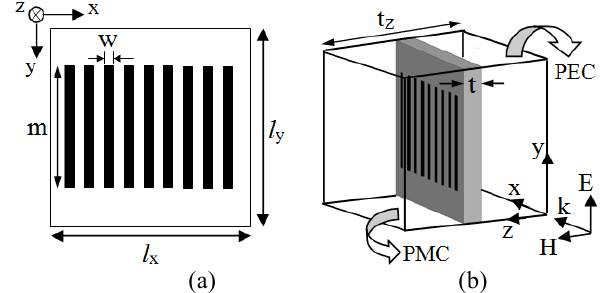
Figure 1: The geometry (a) unit cell metamaterial, (b) its simulation model. The dimensions of unit cell are l x = l y = 6 mm, w = 0.2 mm, t = 0.8 mm and t